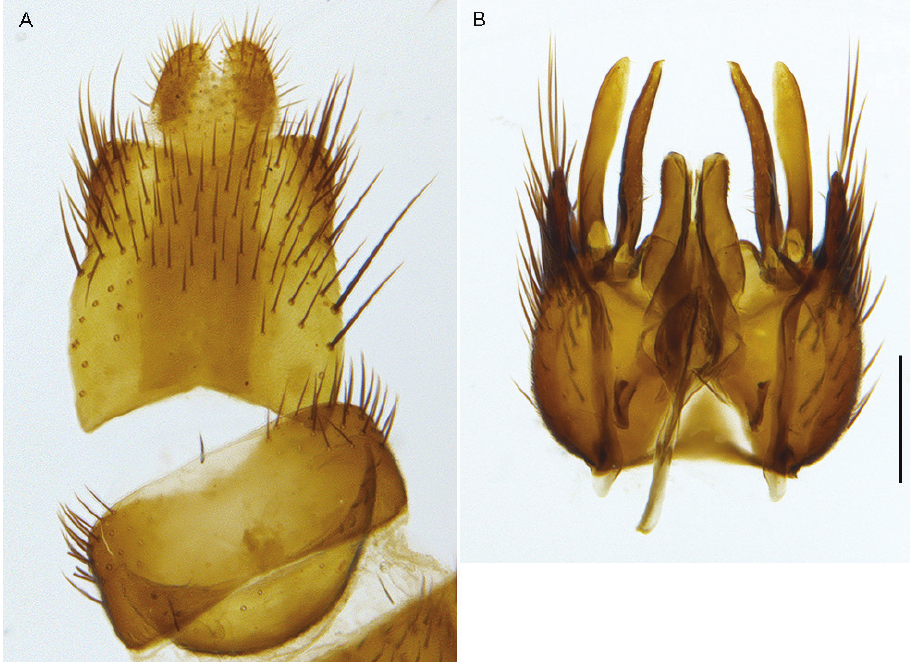
Figure 11. Sidarena geraldton sp. n., male genitalia: A Epandrium and tergite 8, dorsal view B Gono- coxites and aedeagus, dorsal view (epandrium removed). Scale line: 0.2 mm. setae except anepisternum and katatergite which have scattered short, white setae; coxae dark grey pubescent; legs uniformly brown with black setae; chaetotaxy: np, 4; sa, 1; pa, 1; dc, 3; sc 1; wing uniformly tinted infuscate, venation dark. Abdomen . Dark brown- black with cream-yellow areas laterally and on tergite 1, extensive silver velutum on at least tergites 1–4 in male, velutum not unidirectional, but with triangular pattern de- pending on angle viewed; thin setae present on all segments, black medially and poste- riorly, white laterally and anteriorly. Male terminalia . (Fig. 11) Epandrium longer than wide, setae more robust laterally; cerci distinctly separate, ovoid; tergite 8 quadrangular with short robust setae laterally; gonocoxite wider than long; outer gonocoxal process elongate, pointed; inner gonocoxal process elongate, its apex protruding posteriorly to apex of gonostylus but more thinly sclerotized and slightly spatulate apically; gonostylus slender with scattered black setae anteriorly at about 1/3 distance from base to apex; ventral lobe broad and rounded; hypandrium connected to gonocoxite along anterior edge; aedeagus shape similar to other species in